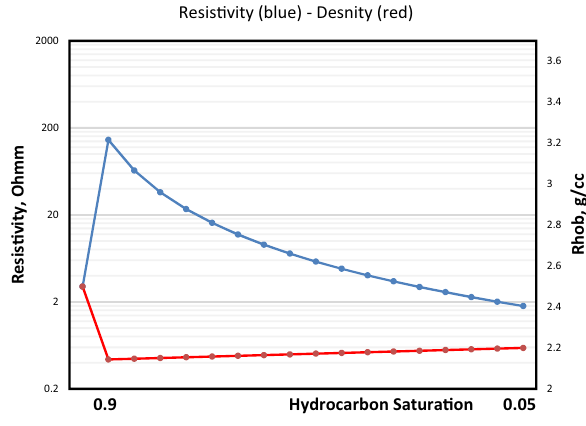
Fig. 2 Density–resistivity overlay, V